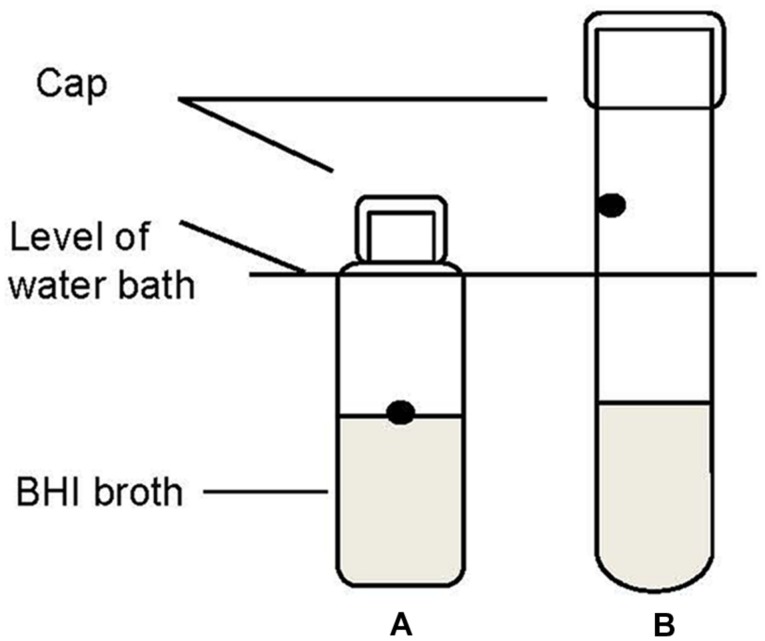
Schematic diagram of method I (A, reference method) and method II (B, alternative method) used to assess the heat resistance of pathogen strains in the water bath. The dots are the spots where cultures were injected.